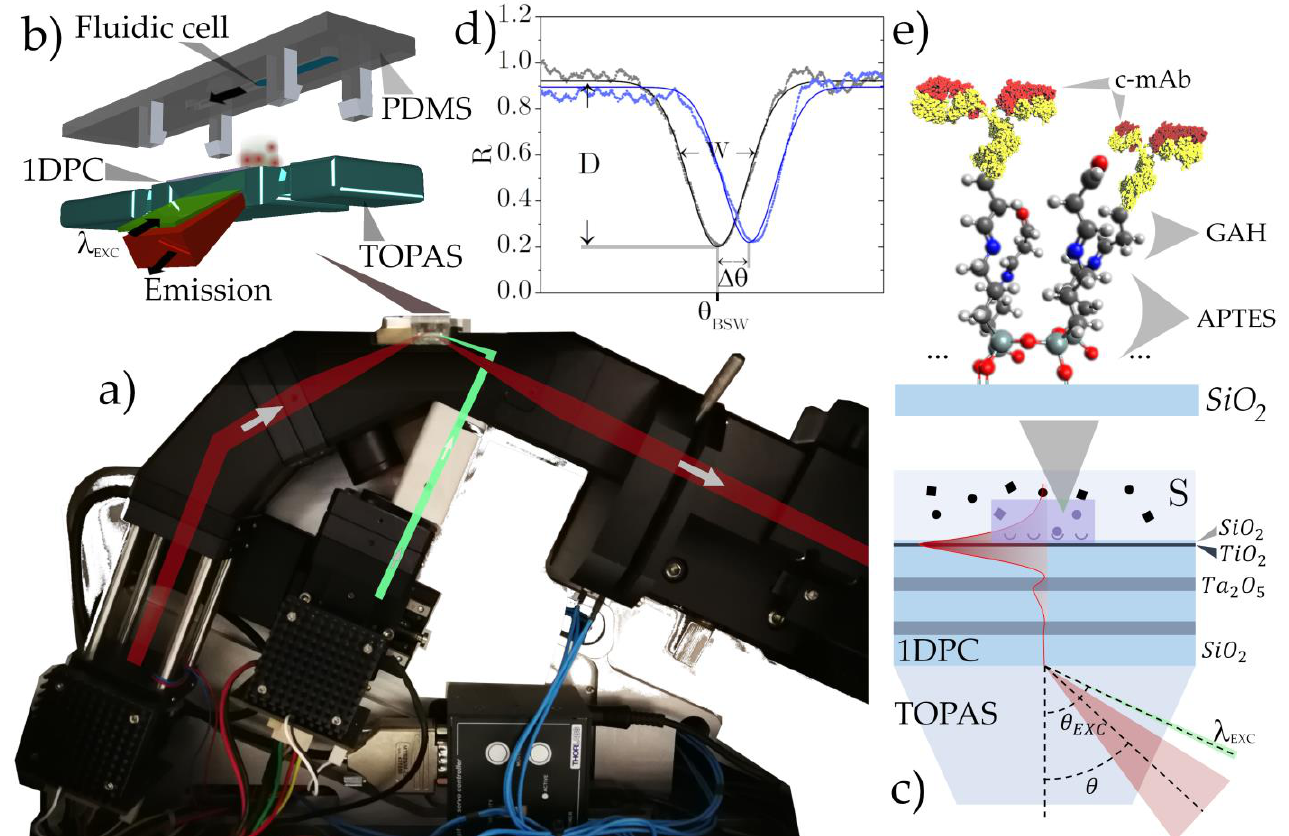
Figure 1. ( a ) Picture of the optical read-out system. The optical path of the illumination beams for the label-free and fluorescence modes are drawn in red and green, respectively. ( b ) Sketch of the biochip, the TOPAS substrate is topped with the 1DPC and the fluidic cell in PDMS. ( c ) Sketch of the Kretschmann–Raether configuration and of the 1DPC design, with the fluorescence excitation beam in green and the fluorescence collection cone in red. The field intensity associated with the BSW is shown in red, with the exponential tail penetrating in the external medium (S). ( d ) Exemplary case of an experimental reflectance profile of a 1DPC when a BSW is excited in TE polarization. ( e ) Sketch of the biosensitive 1DPC top surface (SiO 2 ) (molecules not to